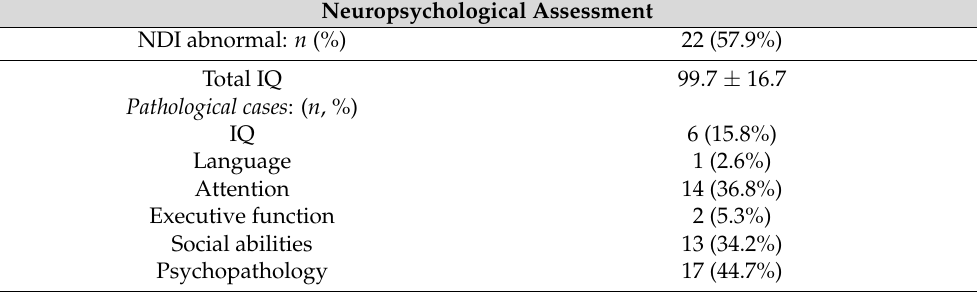
Table 2. Neuropsychological testing results.